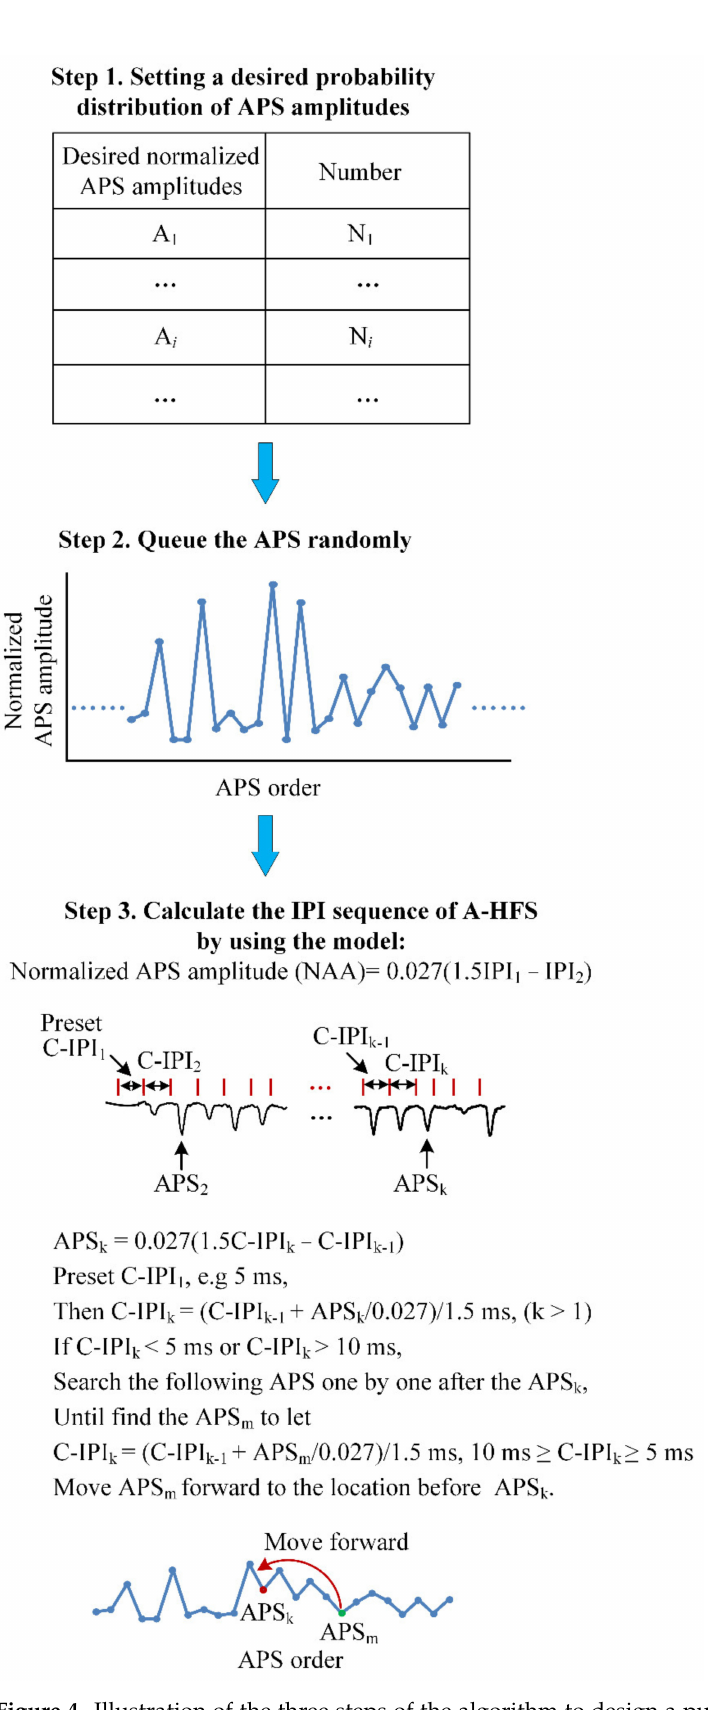
Figure 4. Illustration of the three steps of the algorithm to design a pulse sequence with varying IPI for desired neuronal responses. In step 1, the A i is the setting amplitude of APS, and N i is the corresponding number of APS with amplitude A i